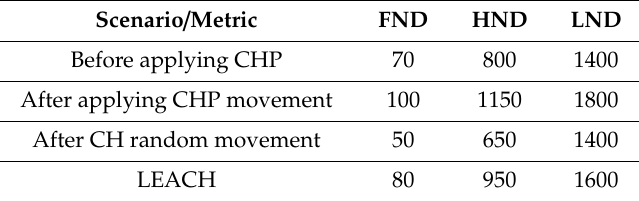
Figure 13. The number of dead nodes after each iteration. Table 2. The FND, HND, and LND metrics for the different scenarios of Figure 13.